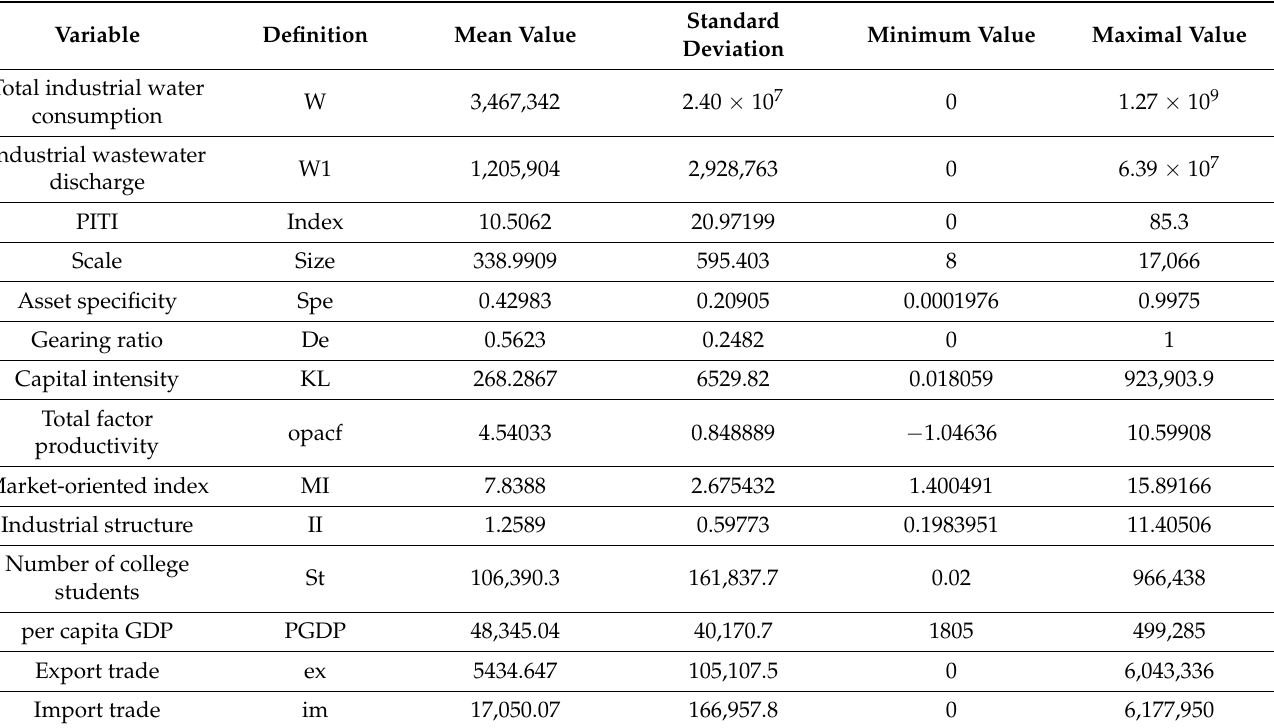
Table 1. Statistical description of the